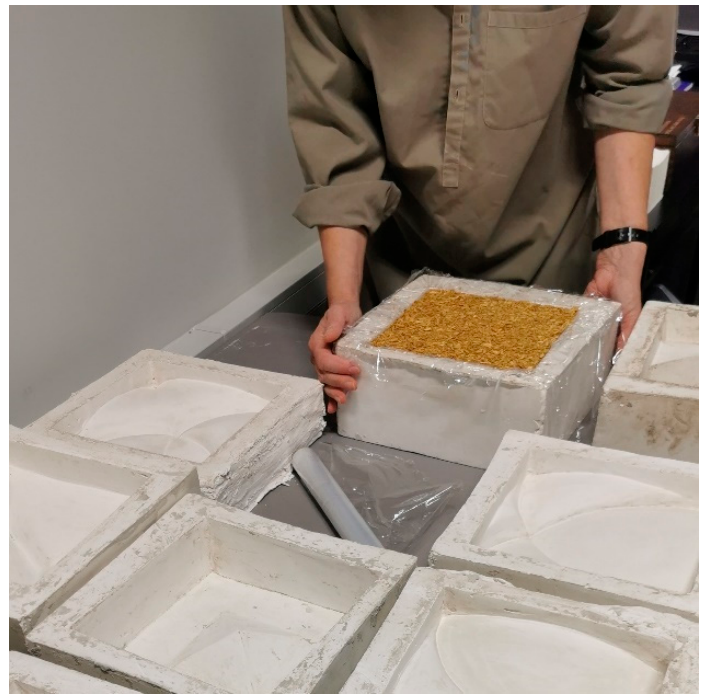
Figure 2. Wall cladding element before ripening—the form filled with MBCs (photo by A.B.).